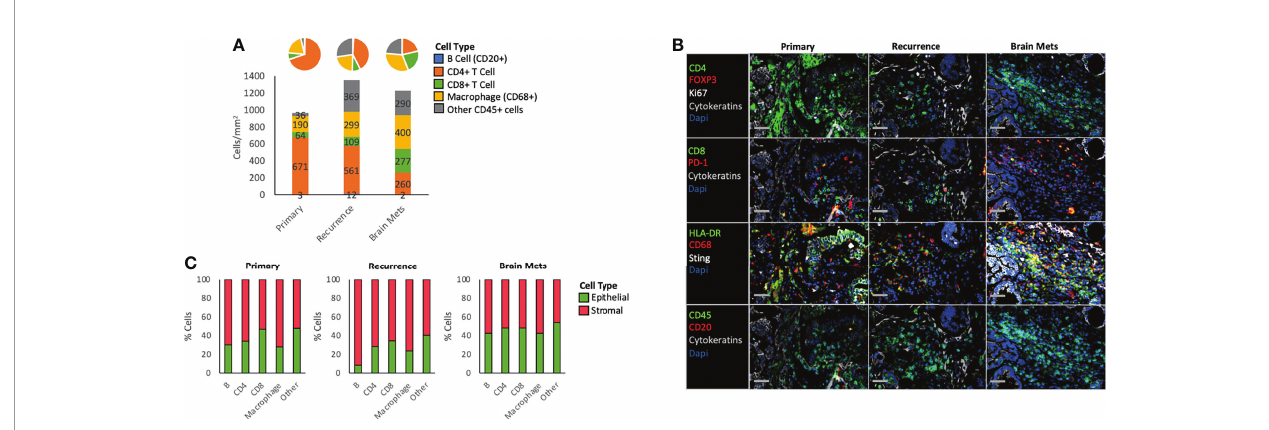
FIGURE 4 | Immune phenotype. (A) Histogram and pie chart showing the density and the proportion of different immune cell populations across all samples. (B) Representative immunostaining of speci fi c markers within each sample. (C) Proportion of each immune cell subtype in the epithelial and the stromal compartments. The percentages were calculated based on the grid analysis. The full name of each protein can be found in Supplementary Table